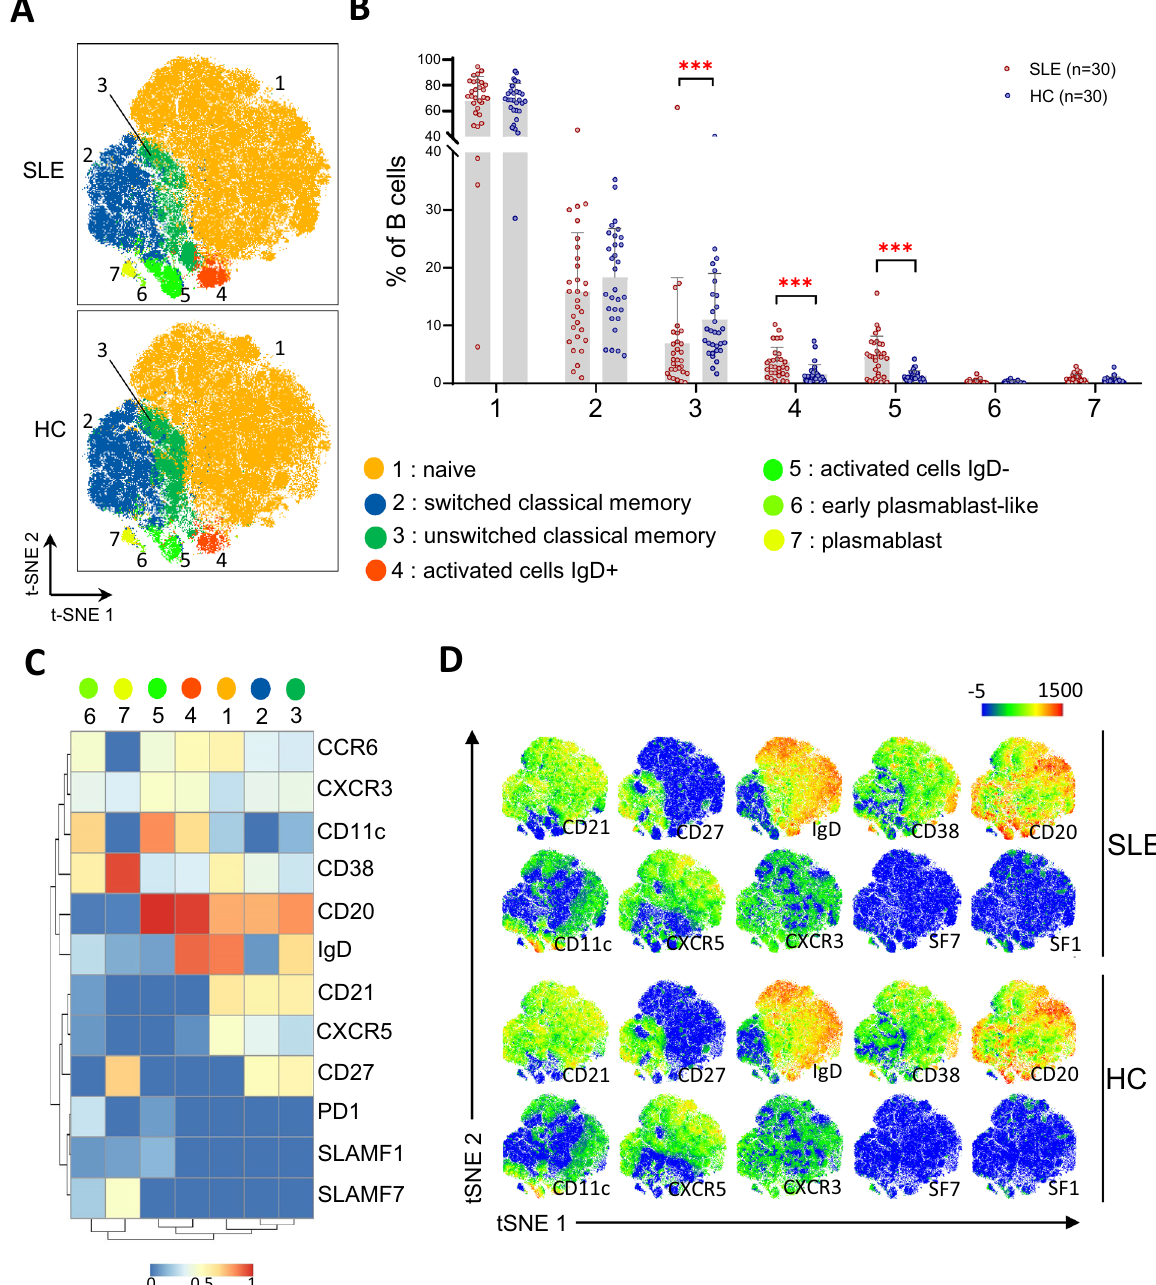
Figure 2. Analysis of B cells phenotype by mass cytometry in systemic lupus erythematosus (SLE) in comparison to healthy controls (HC) using unsupervised clustering analysis. ( A ) Merged t-SNE plots incorporating 120 k B cells from 30 SLE and 120 k B cells from 30 HC and showing B cell clusters identified by FlowSOM unsupervised clustering analysis (each color represents a different cluster). (B) Frequency of each B cell clusters in 30 SLE patients compared to 30 HC. Bar plots represents mean ± SD. Statistical analysis were performed on log-transformed data (to obtain normal distributions) using a student t-test followed by Bonferroni’s correction. ***p value < 0.001. ( C ) Heatmap showing B cell clusters and their scaled mean level of expression of each surface markers used for FlowSOM analysis. ( D ) tSNE plots showing the expression